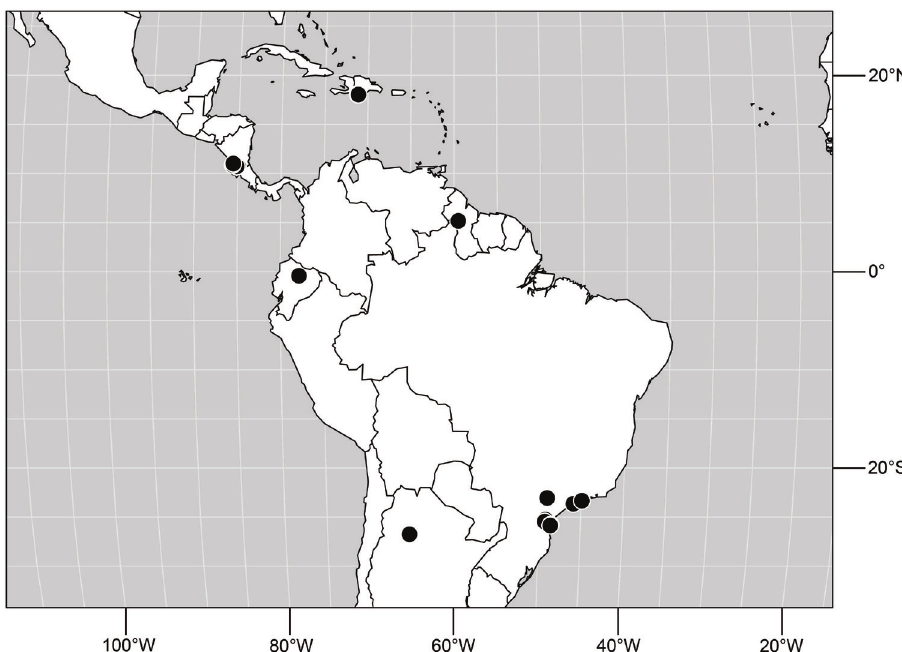
Figure 190. Distribution of Hydrochasma robustum sp.